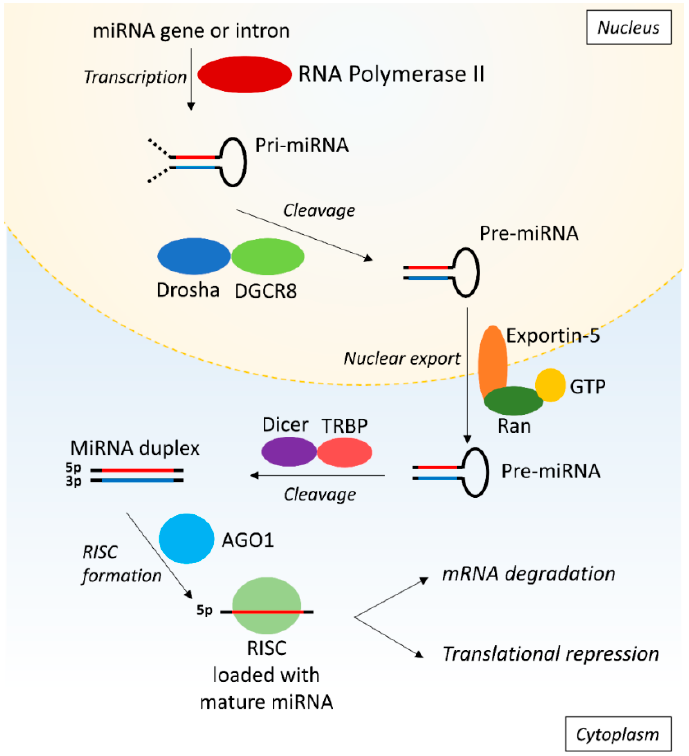
Figure 1. MicroRNA biosynthesis. First, the pri-miR is synthesized from the DNA by RNA polymerase II and is subsequently cleaved by Drosha and DGCR8 into pre-miR. The pre-miR is exported into the cytoplasm by Exportin-5 and Ran-GTP, followed by cleavage into a miR duplex by Dicer and TRBP. One strand is loaded into RISC consisting of AGO1, Dicer and TRBP. The RISC is guided to the target mRNA where the miR induces target degradation or translational repression of the mRNA. AGO1: argonaute 1; DGCR8: Drosha / DiGeorge syndrome critical region gene 8; pre-miR: primary microRNA; pre-mRNA: precursor messenger ribonucleic acid; Ran-GTP: GTP-binding nuclear protein Ran; RISC: RNA-induced silencing complex; RNA: ribonucleic acid; TRBP: tar RNA binding protein.